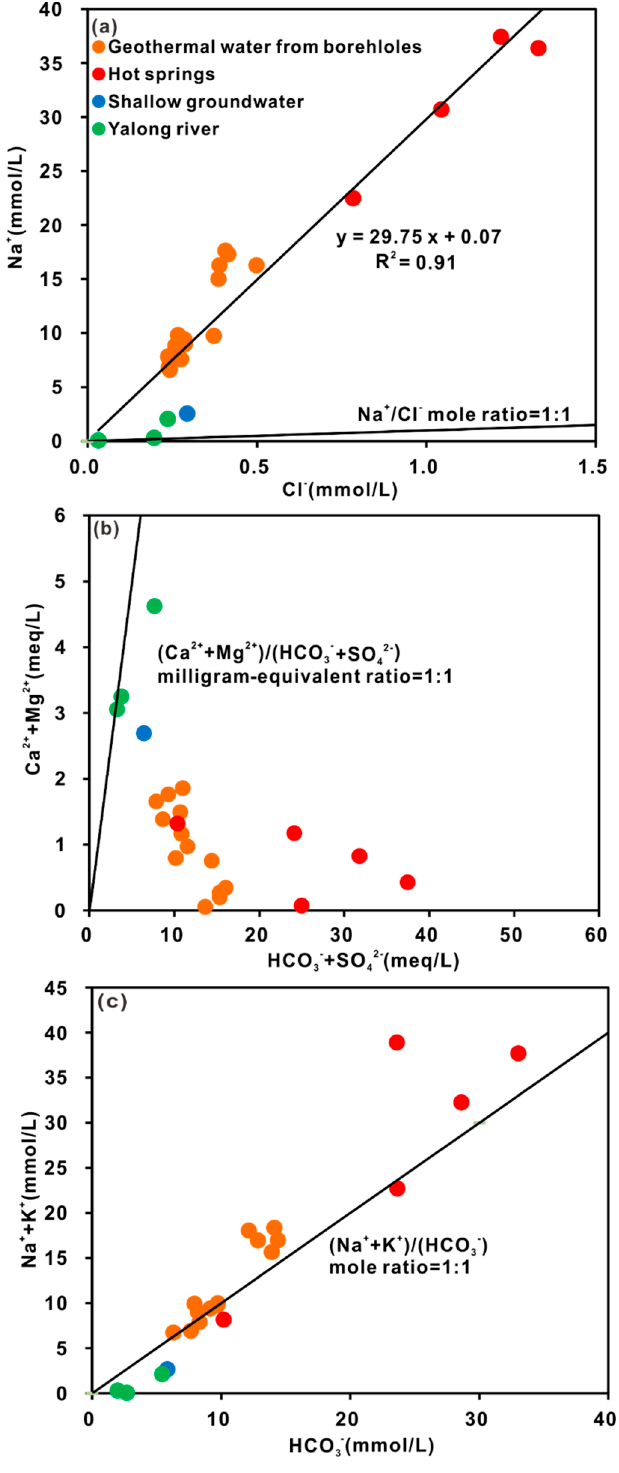
Figure 5. ( a ) Relationship between Na + and Cl − , ( b ) relationship between Ca 2 + + Mg 2 + and HCO 3 − + SO 42 − , ( c ) relationship between Na + + K + and HCO 3 − for water samples from Ganzi.